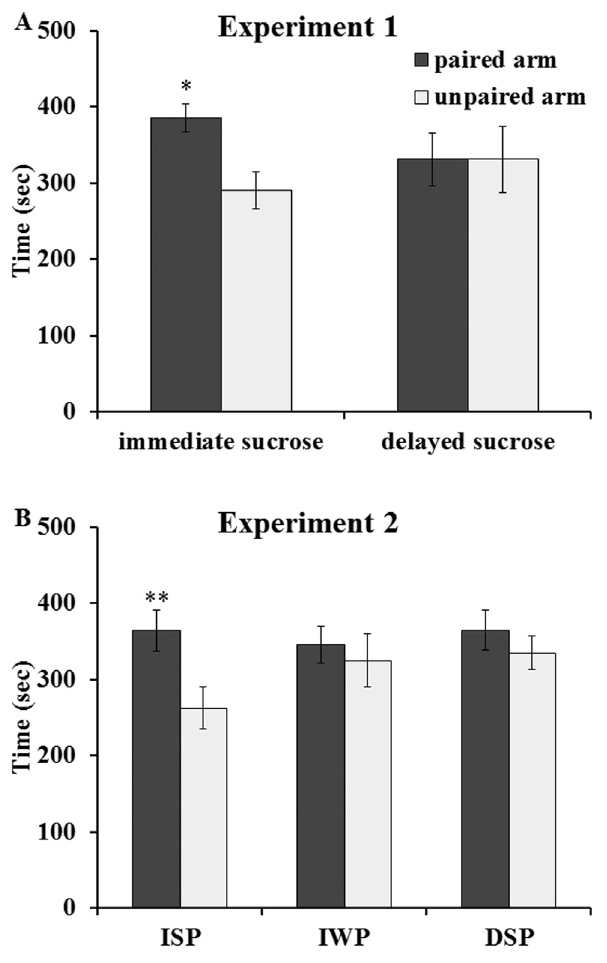
Figure 1. Memory enhancement produced by post-training exposure to sucrose or sucrose-paired cues. A ) Experiment 1: Modulation by Unconditioned Sucrose. The group exposed to sucrose immediately after training on the radial arm maze conditioned cue preference (CCP) task spent more time in the food- paired arm (* p < 0.05 vs. unpaired arm) 24 hours after training while the group exposed to sucrose 2 hours after CCP training did not spend more time in the food-paired arm compared to the unpaired arm. B ) Experiment 2: Modulation by Sucrose-Conditioned Cue. The group exposed to sucrose-paired cues immediately